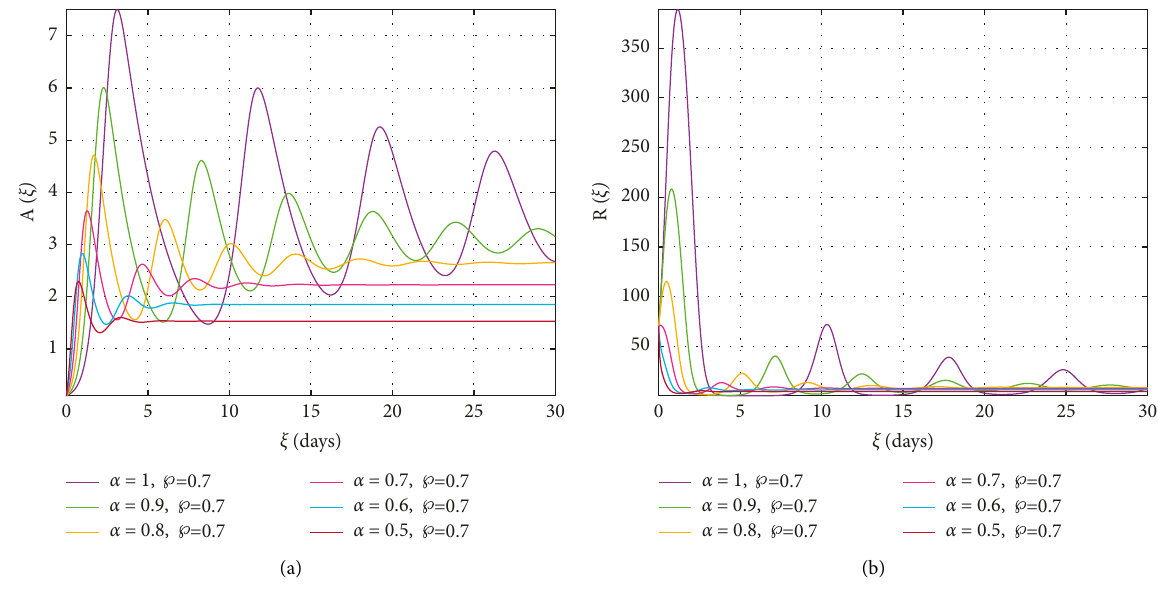
Figure 5: (a) Displays of addicted individuals A ( ζ ) (b) Displays of recovered individuals R ( ζ ) using a Newton polynomial approach for decreasing fractional-order α and fractal-dimension ℘ � 0 .